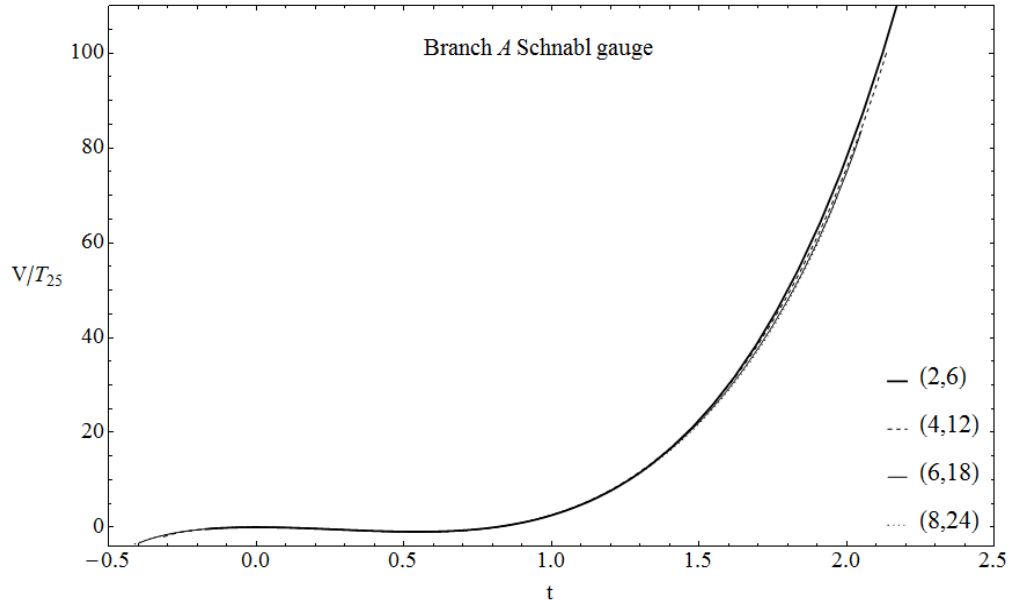
Figure 2 . Branch A of the e(cid:11)ective tachyon potential in Schnabl gauge at di(cid:11)erent truncation